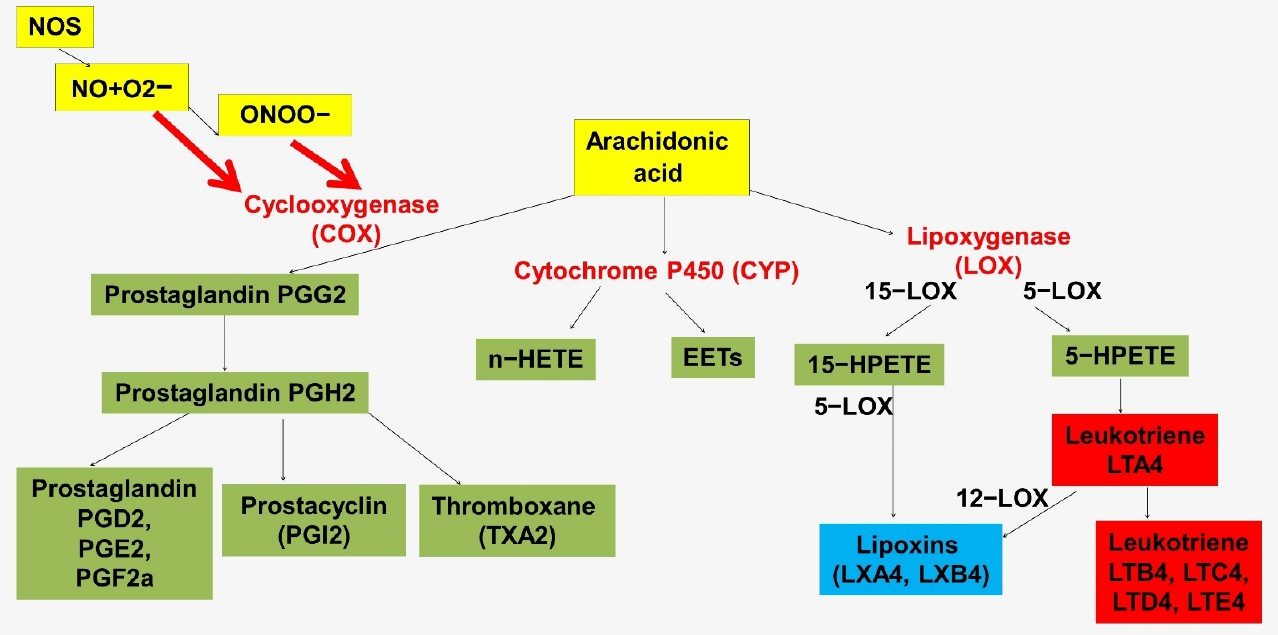
Figure 3. Arachidonic acid metabolic pathways and NO crosslinks. Abbreviations: EETs—epoxyeicosatrienoic acids; HETE—hydroxyicosatetraenoic acid; NOS—nitric oxide synthase; 5 − HPETE—5 − hydroperoxyeicosatetraenoic acid; 15 − HPETE—15 − hydroperoxyeicosatetraenoic acid; 5 − LOX—5 − lipoxygenase; 12 − LOX—12 − lipoxygenase; 15 − LOX—15 − lipoxygenase